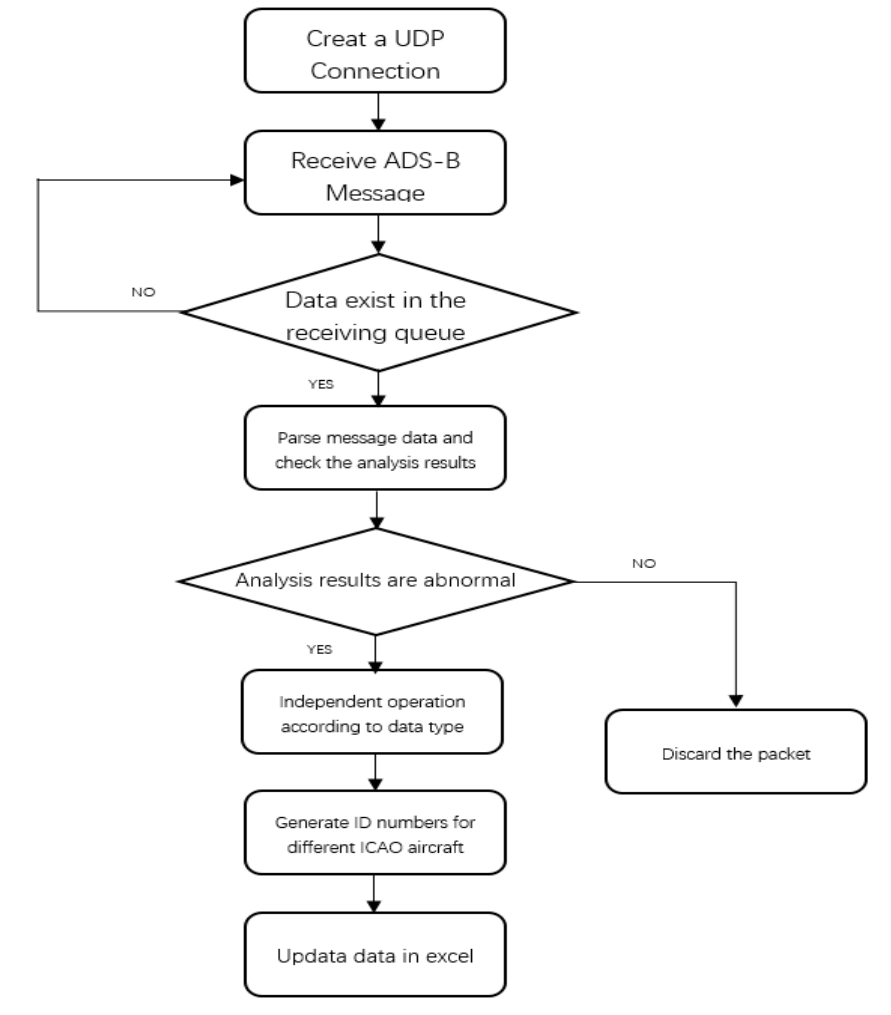
Figure 16. ADS-B message decoding software flow chart. Table 3. Part of aircraft information.